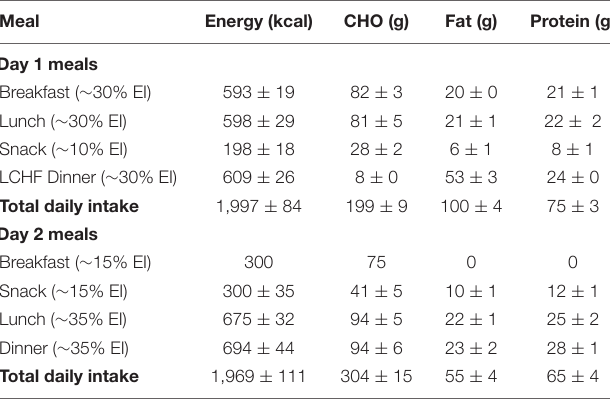
TABLE 2 | Nutritional composition of standardized